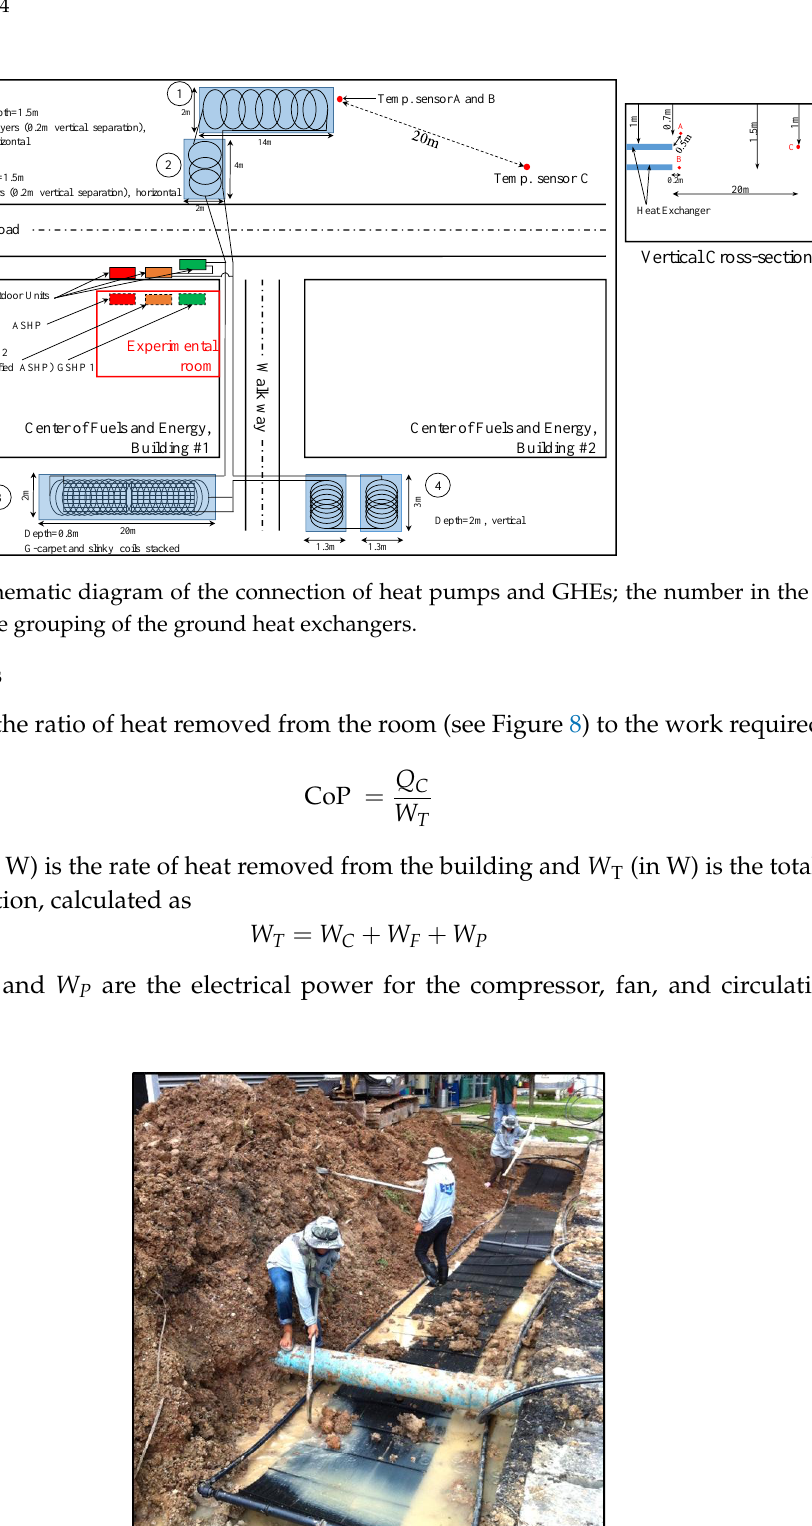
Figure 5. Installation of high-density polyethylene (HDPE) slinky pipes (Group 1).